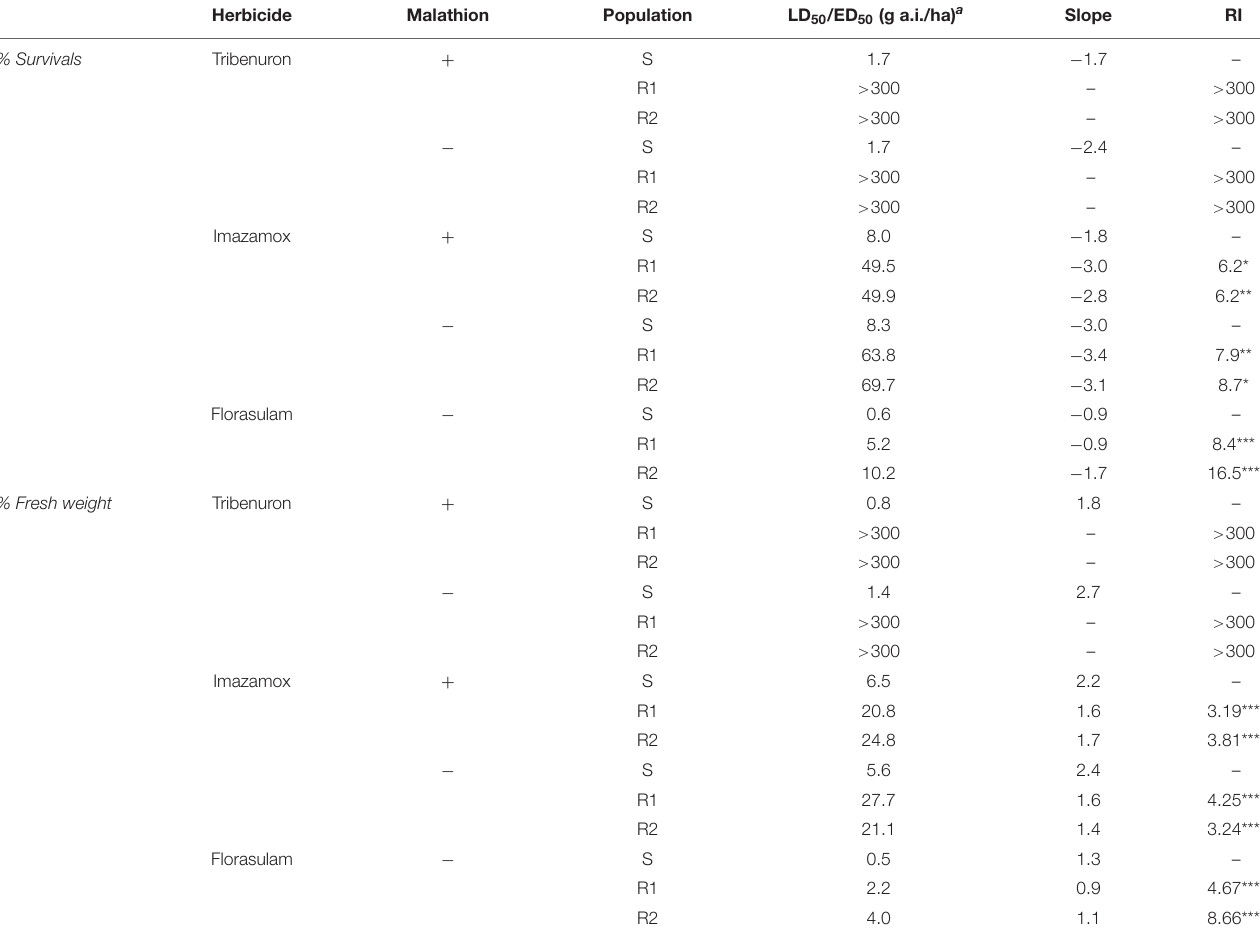
TABLE 2 | Parameters of the log-logistic equation of the dose–response regression curves of survival and fresh weight in G. coronaria S and R (R1 and R2) populations in presence and absence of